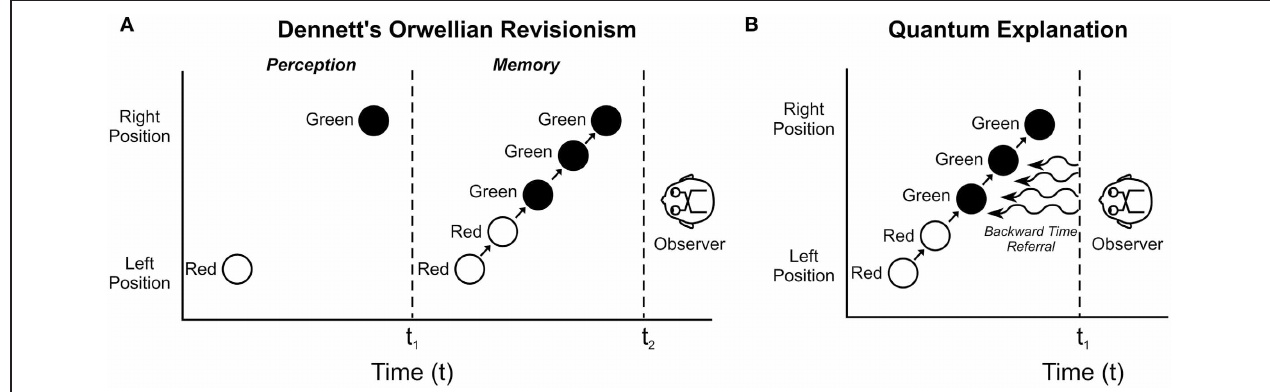
FIGURE 7 | In the “color phi” phenomenon (Kolers and von Grunau, 1976). A red circle appears on the left side of a screen, disappears, and then, a fraction of a second later, a green circle appears on the right side. An observer consciously “sees” a red circle moving continuously from left to right, changing to green halfway across. (A) According to Dennett’s